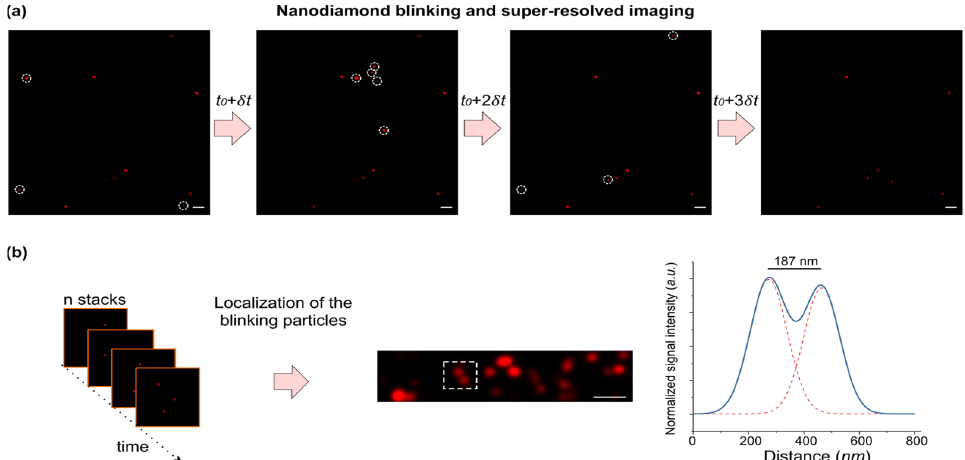
Figure 4. ( a ) A time-series of microscopic images in the nanodiamond channel. Some particles with fluctuating emissions are highlighted with a dashed circle. Scale bars, 10 µm. ( b ) (left) A localization algorithm can be applied on the image series for the detection of single particles. (middle) An example of a super-resolved image over time. (left) The intensity profile (of the region indicated in the middle image with dashed lines) is shown. Two fitted gaussian curves with a distance of 187 nm indicate the distance of two particles beyond the diffraction-limit (i.e., λ /2~325 nm).